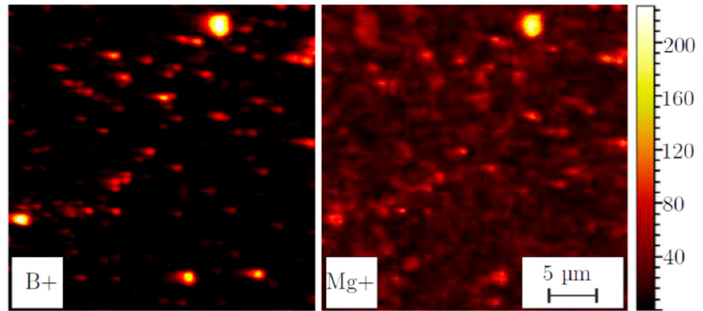
Figure 4. ToF-SIMS (flight of time secondary ions mass spectrometry) mapping on the cross section of an AMC reinforced with 10 vol % SiC and 3 vol % boron; matrix material: AA2017; size of the SiC and B particles: about 1 μ m.